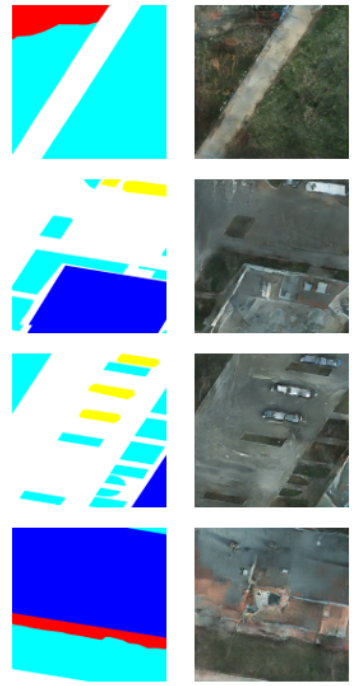
Figure 10. Translation of images from the label domain to the source domain using the second GAN